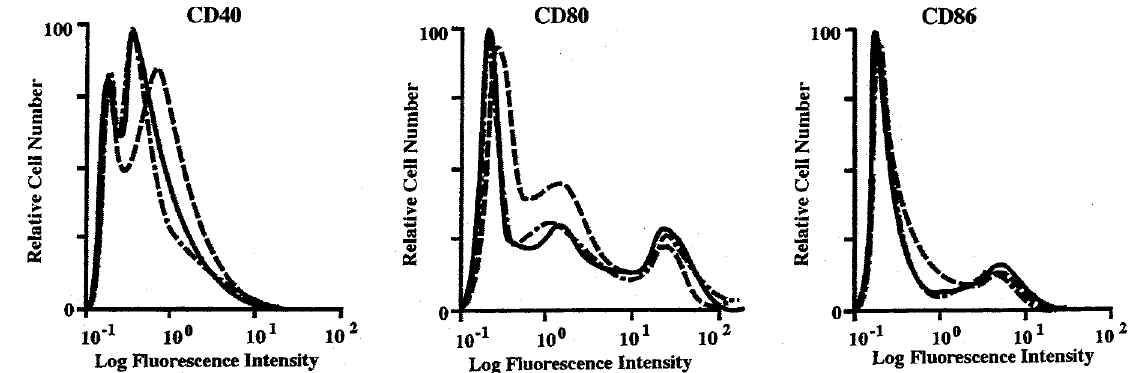
FIG. 2. Influence of epinastine hydrochloride (EP) on co-stimulatory molecule expression on spleen cells induced by antigenic stimulation. Spleen cells (1 ´ 10 6 cells/ml) prepared from five individual mice 10 days after immunization were cultured with or without 2 ´ 10 –4 M EP for 24h. The expression was analyzed by flow cytometer: (____) cultured without antigen; (_ _ _ _) cultured with antigen; (_ · _ · _) cultured with antigen and EP.